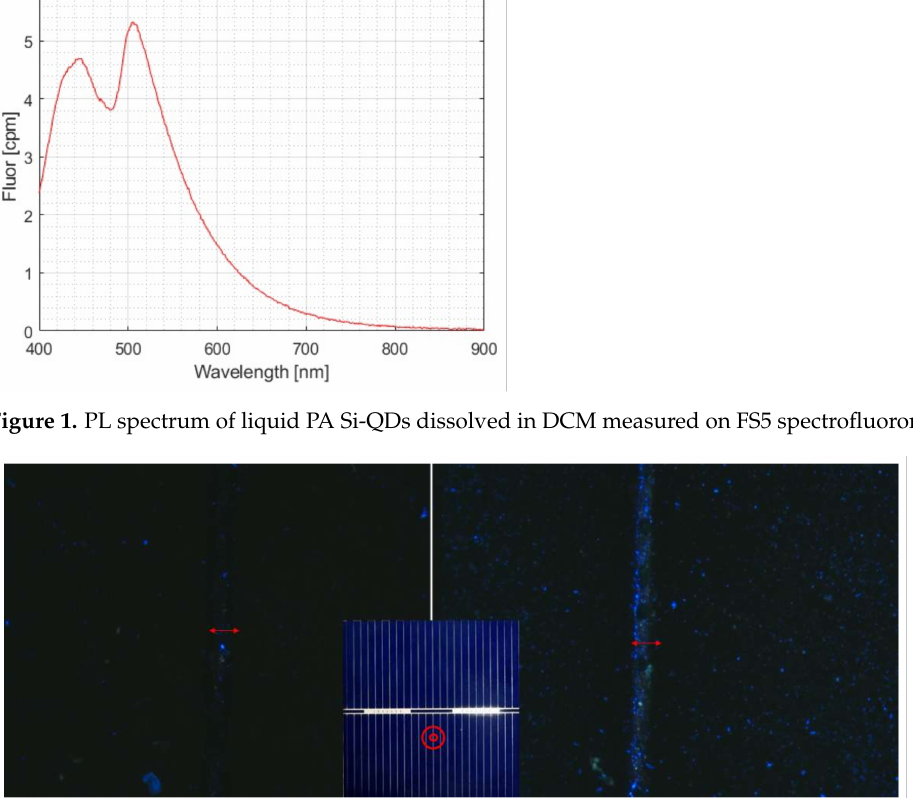
Figure 2. Fluorescence microscopy of two poly-Si solar cells; on the left, the fluorescence image of the bare cell, and on the right the fluorescence image of the coated sample with PA Si-QDs; in the middle is the image of the bare pc-Si solar cell the double circles pointing to the region of × 10 fluorescence microscopy. The arrows indicate the position of a silver